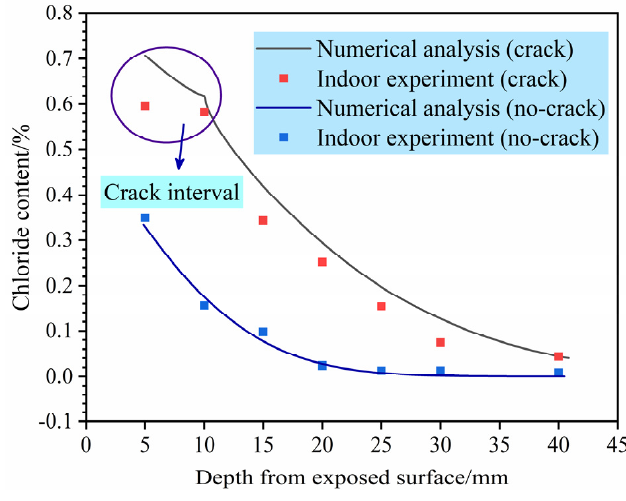
Figure 10. Comparison of chloride content determined analytically and experimentally.